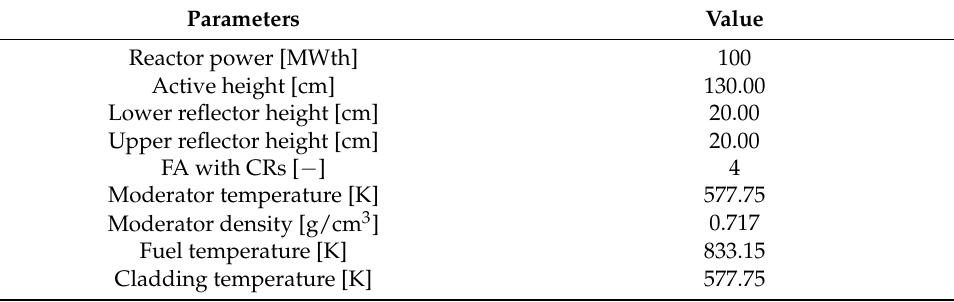
Table 1. 32 FA PWR minicore layout and conditions.